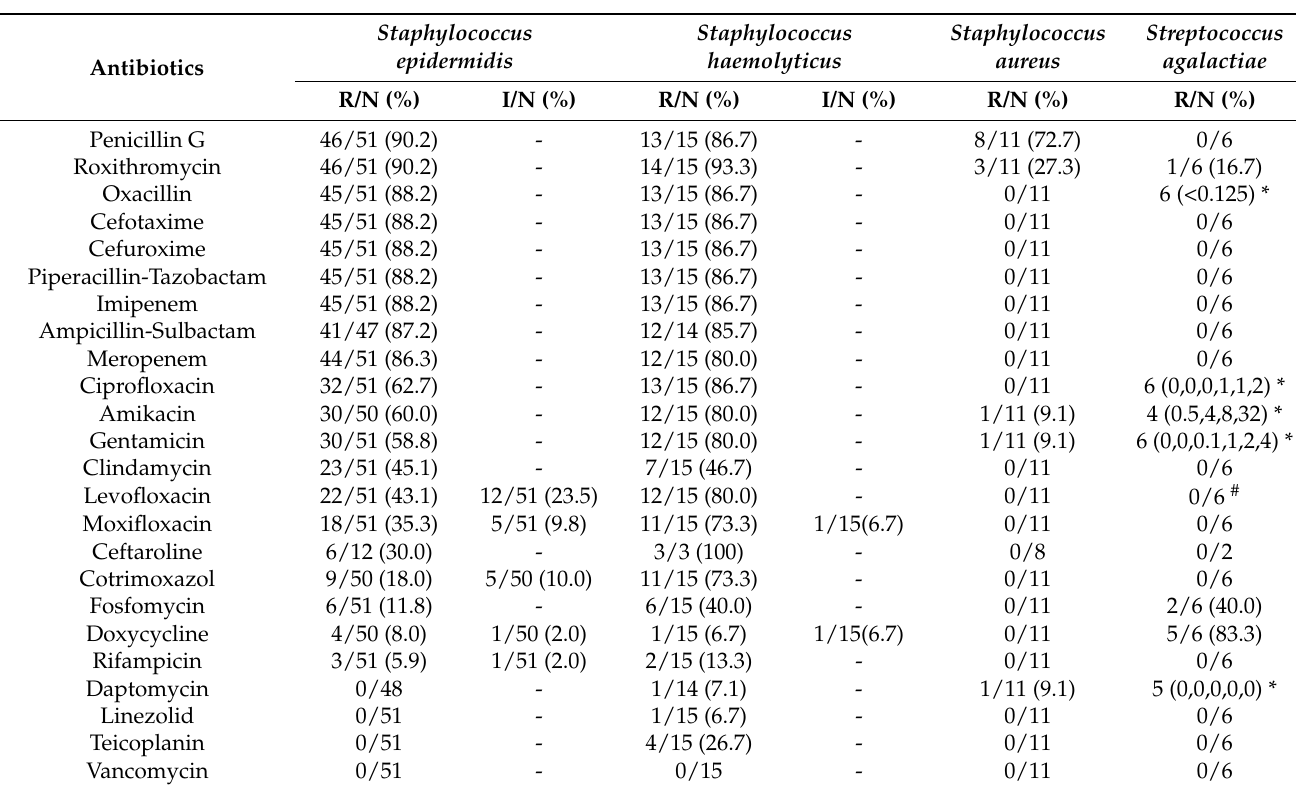
Table 2. Antibiotic resistance patterns of predominant gram positive bacterial isolates from neonatal sepsis patients,